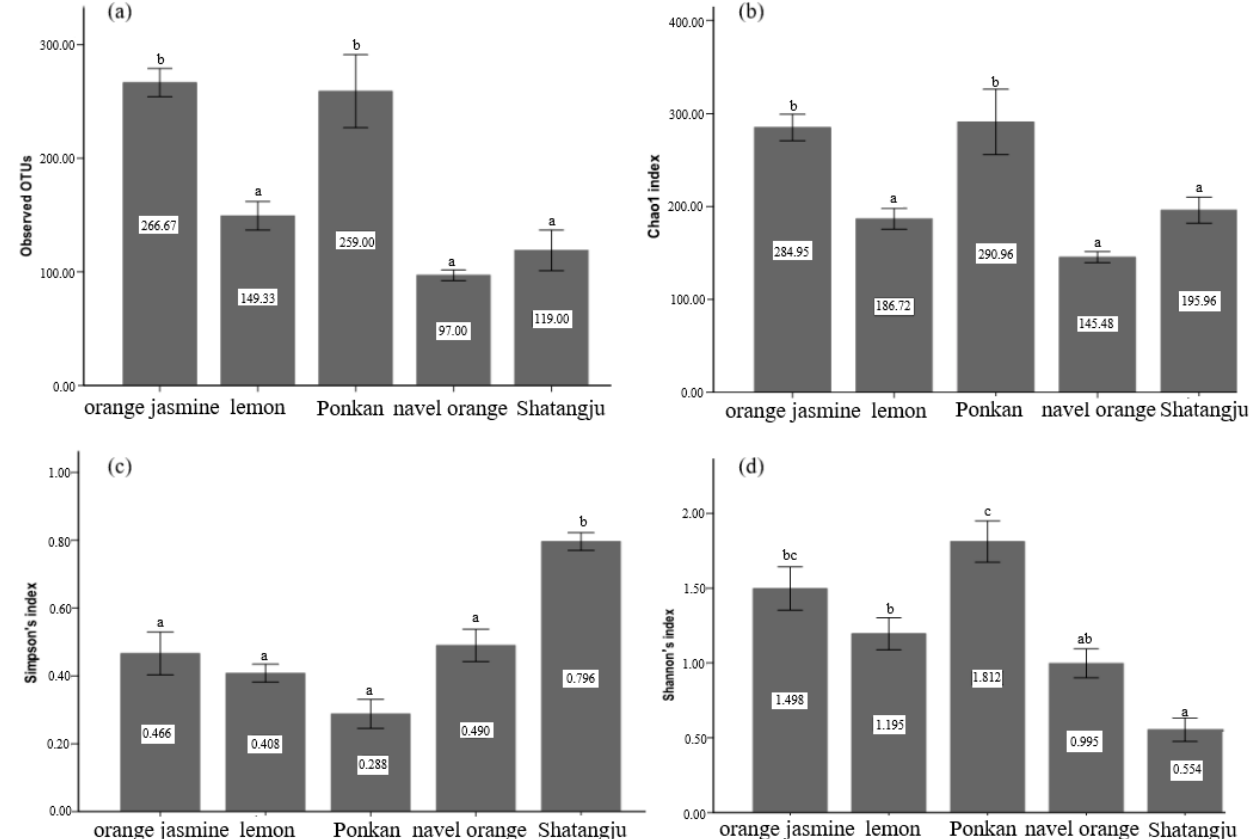
Figure 1. Measures of the α -diversity for each treatment: ( a ) observed OTUs; ( b ) Chao richness estimator; ( c ) Simpson’s index; ( d ) Shannon’s index. Different letters indicate that the values are significantly different ( p < 0.01) .